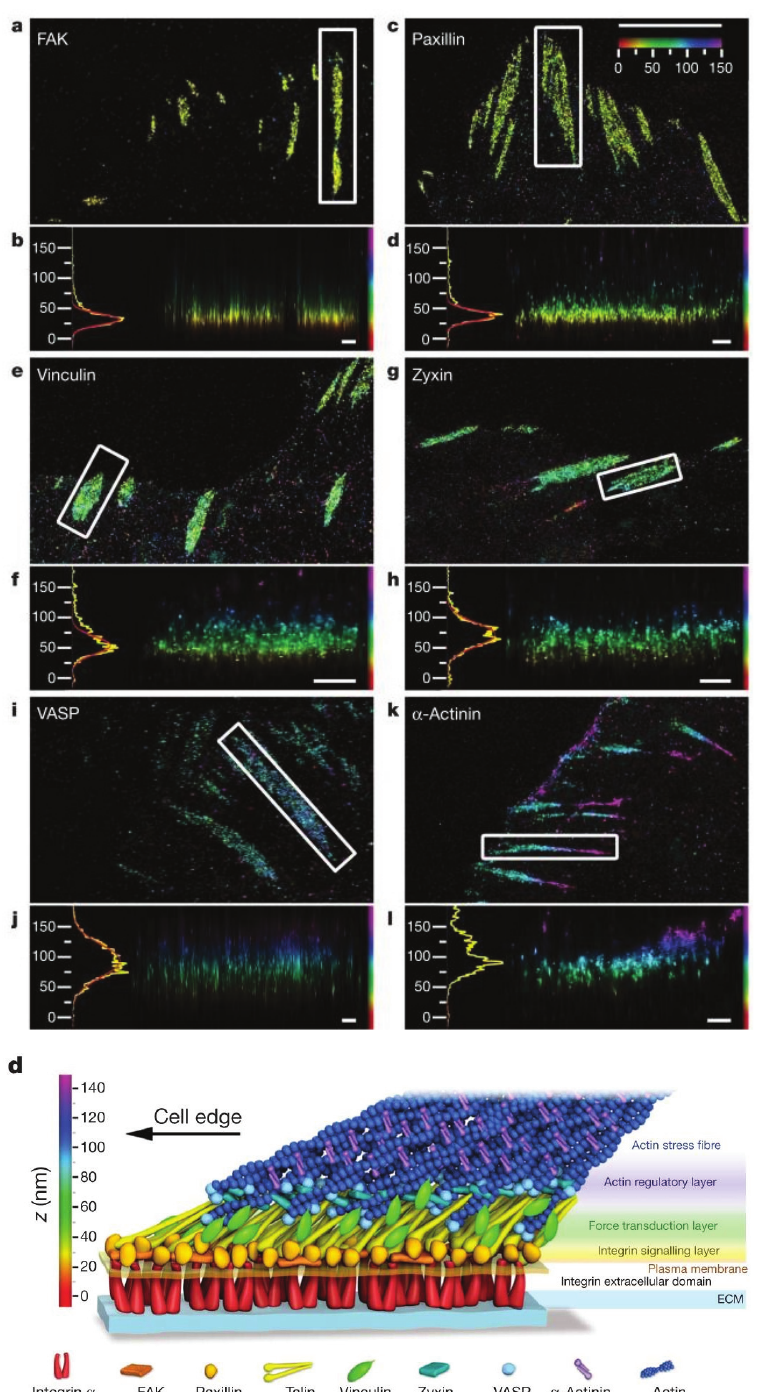
Figure 4. Protein stratification of the focal adhesion core. Top view and side view “interferometric” photo-activated localization microscopy (iPALM) images of focal adhesions (white boxes, top-view panels) and corresponding z histograms and fits. ( a , b ) FAK. ( c , d ) Paxillin. ( e , f ) Vinculin. ( g , h ) Zyxin. ( i , j ) VASP. ( k , l ) Alpha-actinin. The vertical distribution of α -actinin is non-Gaussian, so the focal adhesion peak fit is not shown. Paxillin and α -actinin shown are C-terminal photo-activatable fluorescent protein (PA-FP)-tagged. Colors: vertical ( z ) coordinate relative to the substrate ( z = 0 nm, red). (d, bottom panel). Schematic model of focal adhesion molecular architecture depicts experimentally determined protein positions. Note that the model does not depict protein stoichiometry. Scale bars = 5 μm (a, c, e, g, i, k) and 500 nm (b, d, f, h, j, l). ECM, extracellular matrix. Taken from